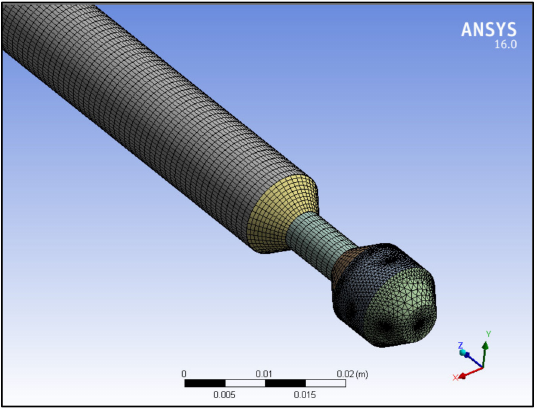
Figure 12. Meshing schemes of the established